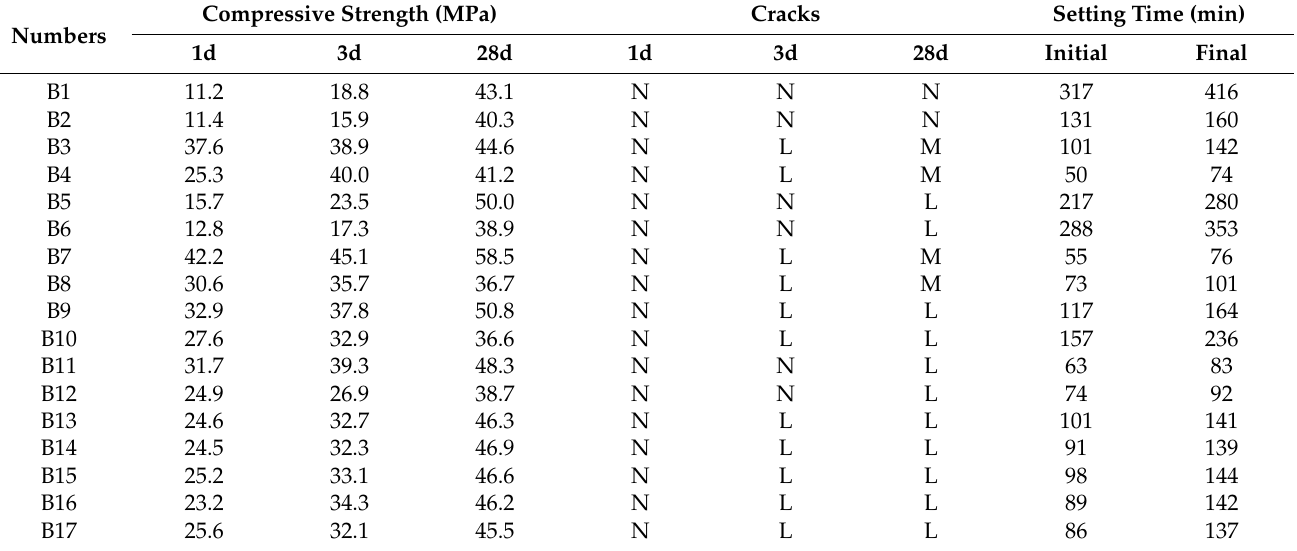
Table 6. Test results of